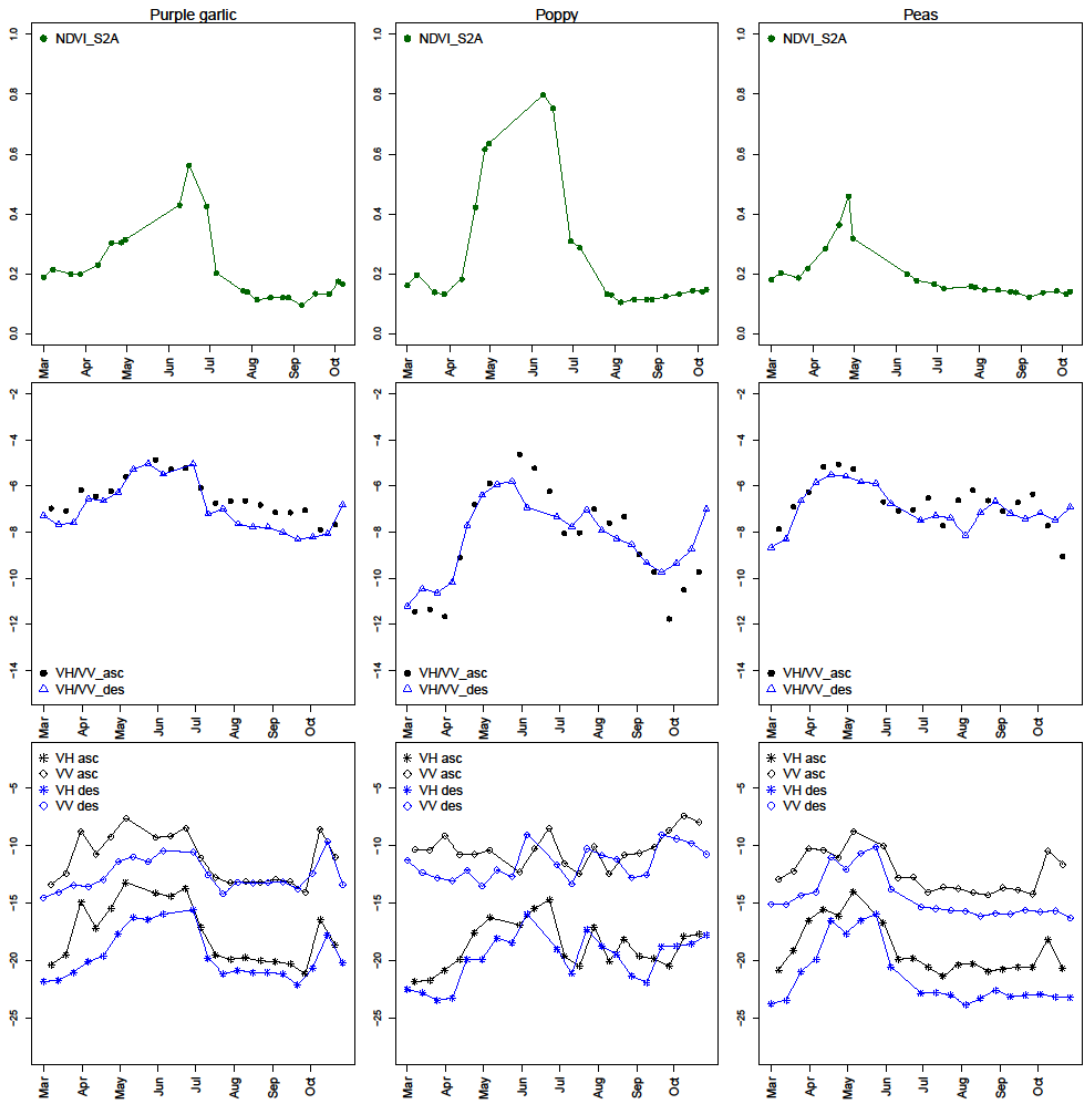
Figure 6. Temporal signatures of purple garlic, poppy, and peas for NDVI, CR, VH, and VV. Two relative descendant (des) and ascendant (asc) orbits are represented in black and blue, respectively.